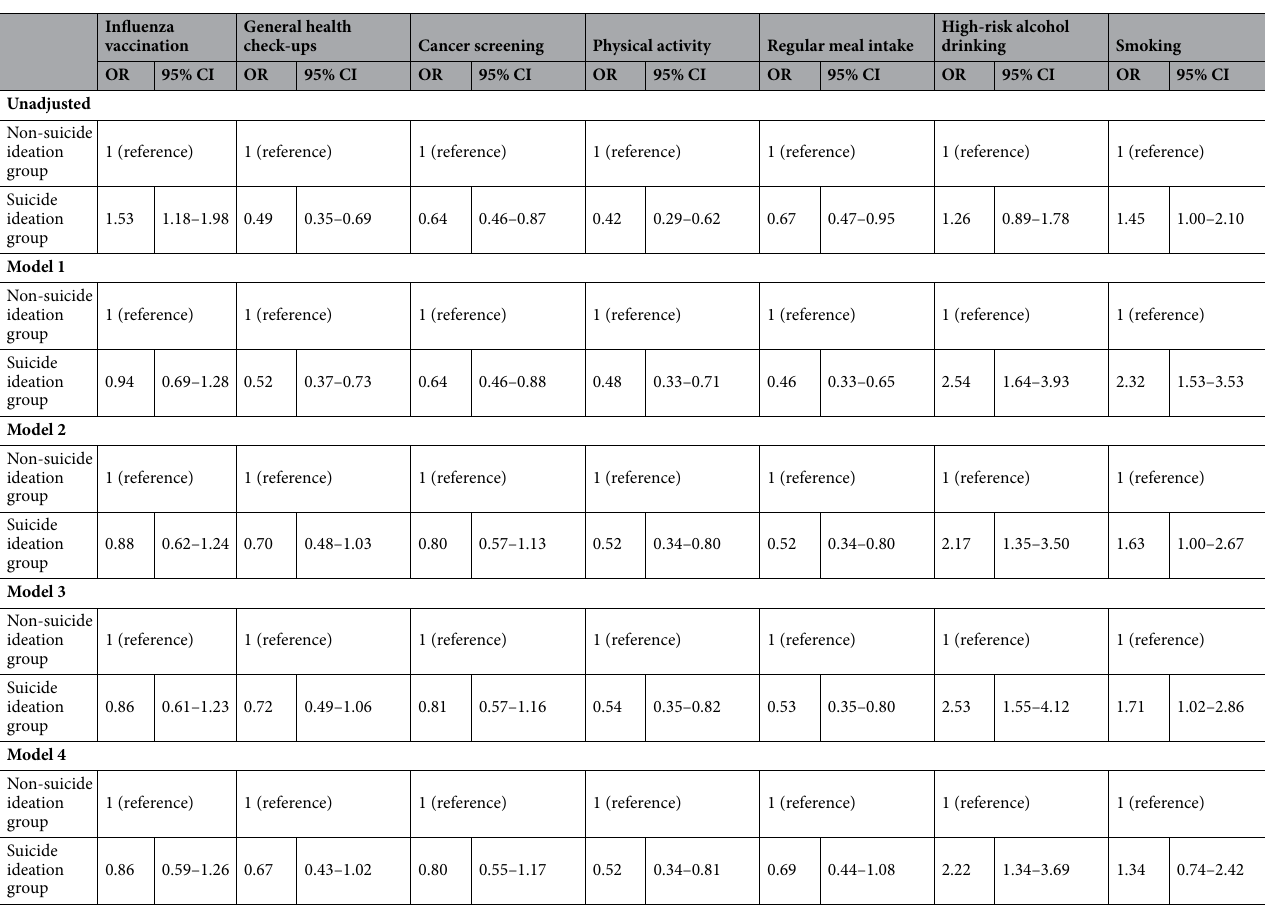
Table 2. Crude and adjusted associations of suicide ideation with preventive health behaviors in four steps of adjustment for covariates. OR odds ratio, CI confidence interval. In model 1, sex and age were